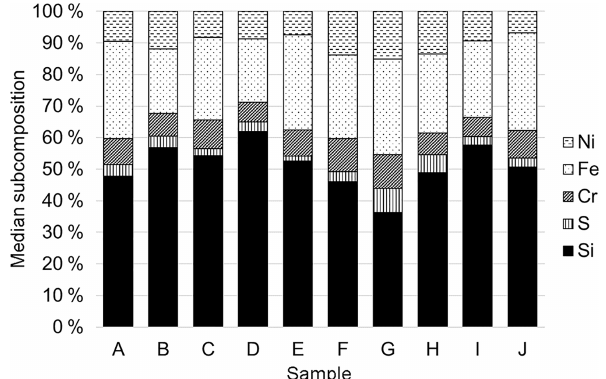
Figure 4. Median chemical subcomposition (atom%, without C and O) of refractory carbonaceous particles determined by SEM-EDX (30 particles per sample). Sample K was excluded from the figure due to a different substrate with higher Si